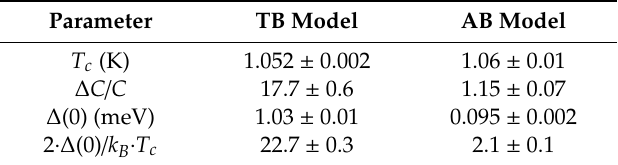
Table 1. Deduced parameters for tantalum / graphene / tantalum (Ta / G / Ta) junction from fit to single-band Titov and Beenakker (TB) [53] and Ambegaokar and Barato ff (AB) [7,8]